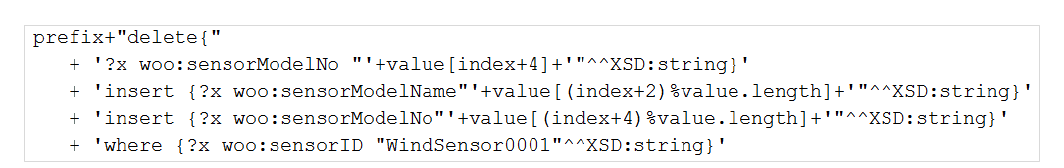
Figure 24. VO description in OWL.